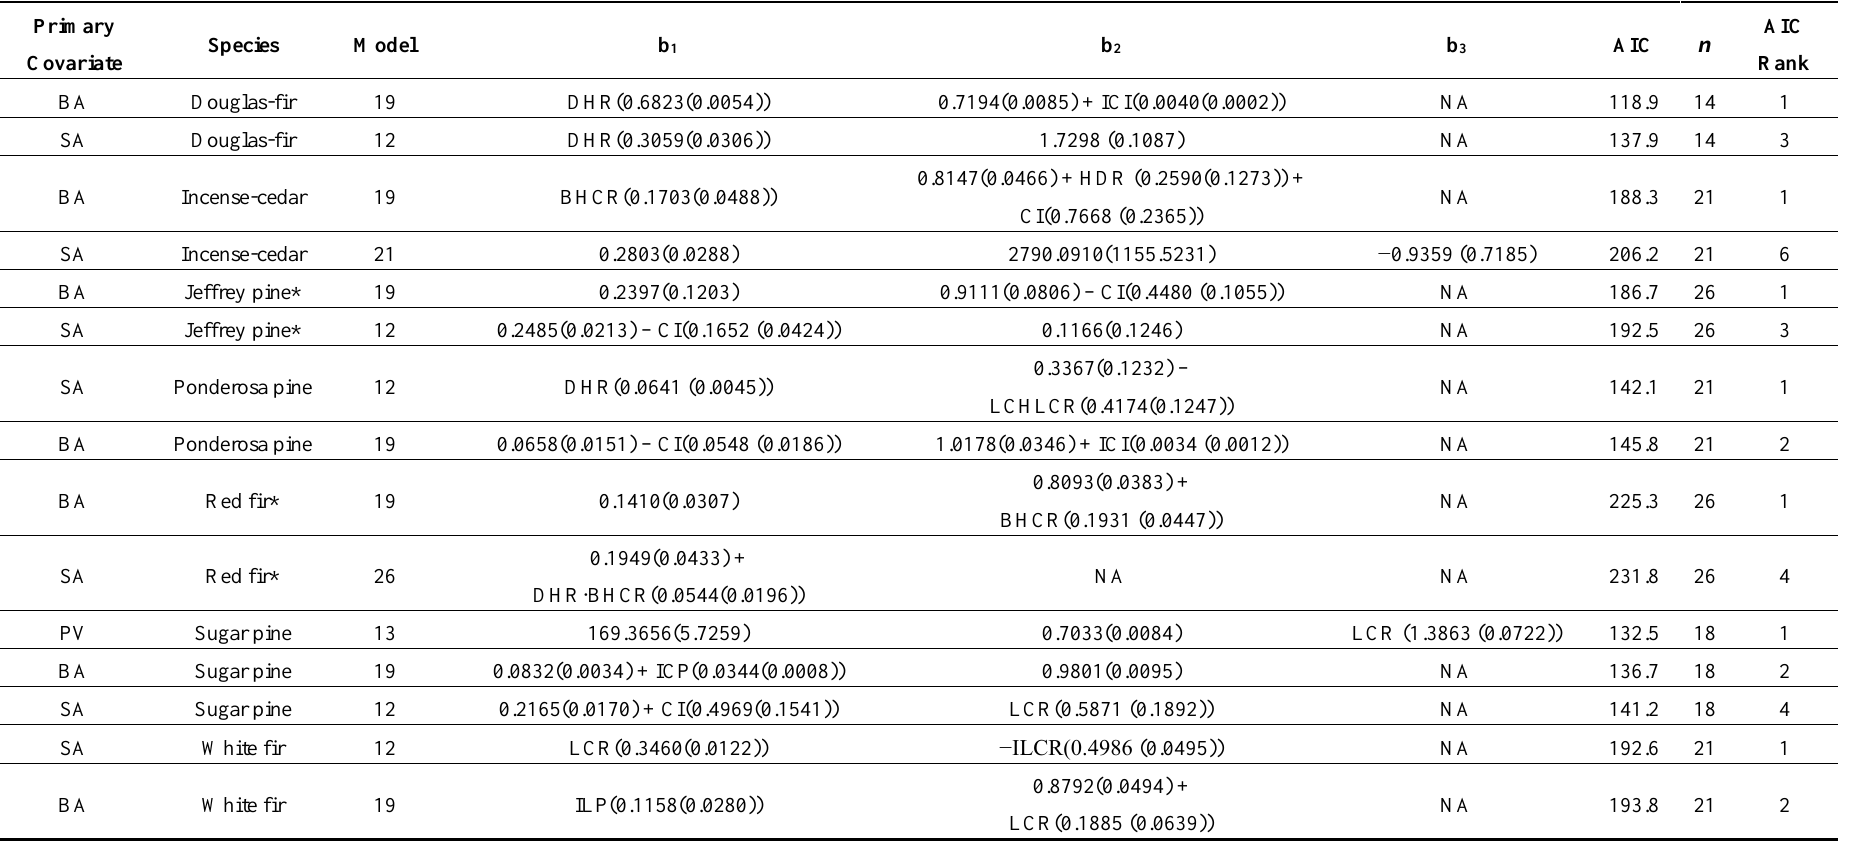
Table 7. Summary of parameter estimates for whole tree leaf area prediction models by